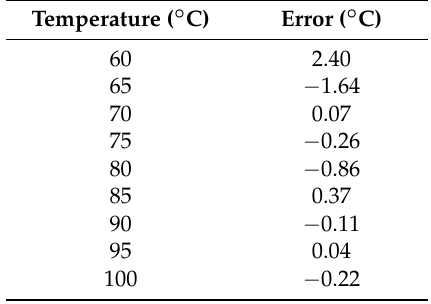
Table A1. Temperature measurement error of calculated value and heated